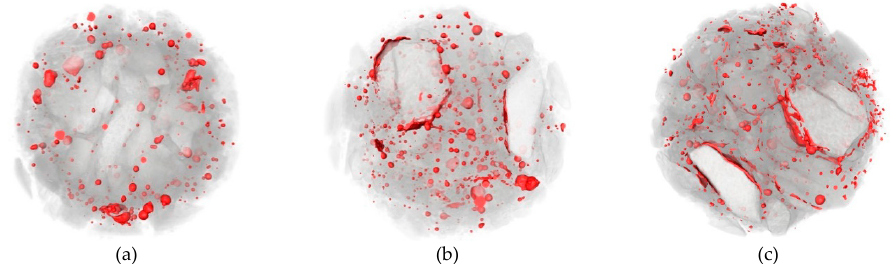
Figure 17. Pore distribution under di ff erent freezing and thawing cycles of 0.6% 15 nm-NS added Figure 17. Pore distribution under different freezing and thawing cycles of 0.6% 15 nm-NS added concrete. ( a ) 25 FTCs; ( b ) 50 FTCs; ( c ) 75 FTCs. Figure 17. Pore distribution under different freezing and thawing cycles of 0.6% 15 nm-NS added concrete. ( a ) 25 FTCs; ( b ) 50 FTCs; ( c ) 75 FTCs. concrete. ( a ) 25 FTCs; ( b ) 50 FTCs; ( c ) 75 FTCs. concrete. ( a ) 25 FTCs; ( b ) 50 FTCs; ( c ) 75 FTCs.